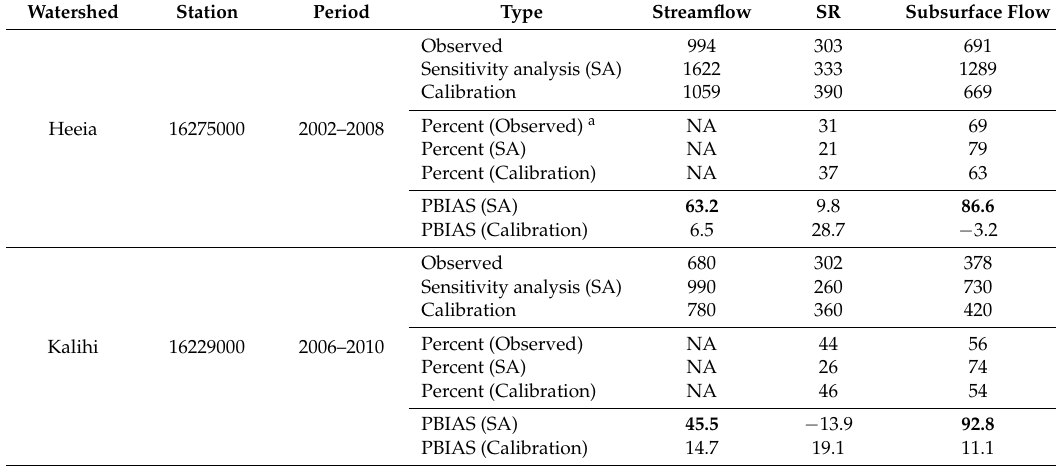
Table 4. Observed and simulated annual average streamflow, surface runoff (SR), and subsurface flow (SSF) (in mm) and percentages of SR and SSF relative to total streamflow for Heeia and Kalihi. Bold signifies